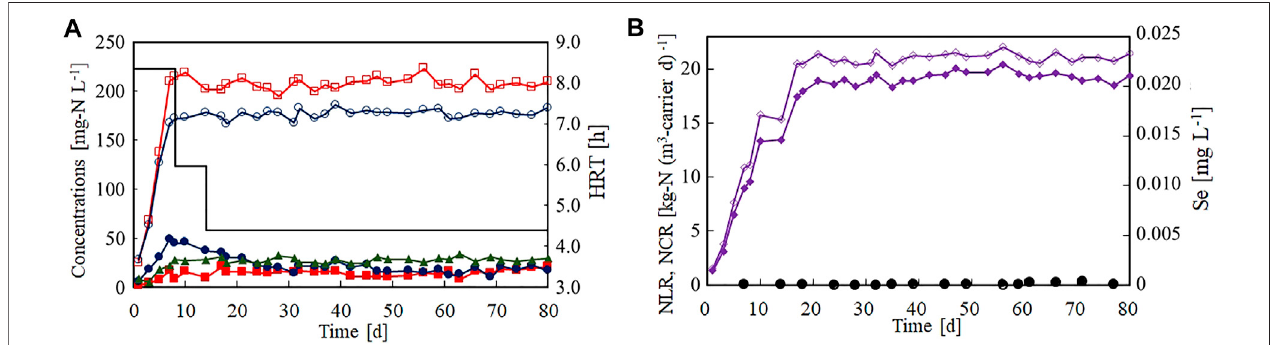
FIGURE2| Start-upoftheanammoxreactorpackedwithpolyethyleneglycolgelcarrierintheSe(VI)-limitationexperiment. (A) Timecoursesofin fl uentammonium (opencircles), in fl uent nitrite (open squares), ef fl uent ammonium ( fi lledcircles),ef fl uent nitrite ( fi lledsquares), and ef fl uent nitrate( fi lledtriangles). Thebar graph shows the hydraulic retention time on each day. (B) Time courses of nitrogen loading (open diamonds) and nitrogen conversion rate ( fi lled